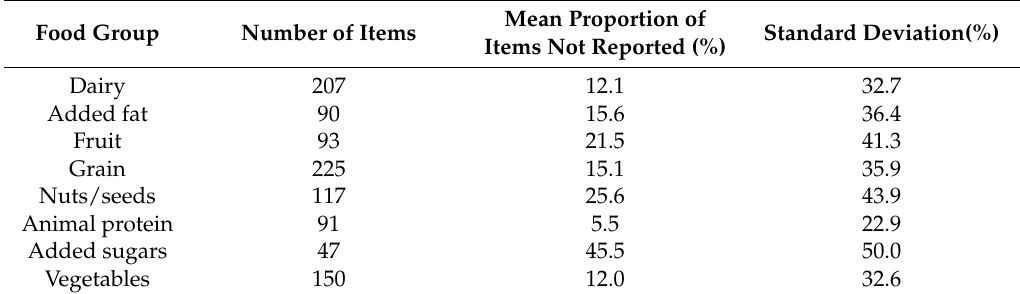
Table 2. Descriptive statistics of items not reported during ASA24 recall by food group in overweight and obese female